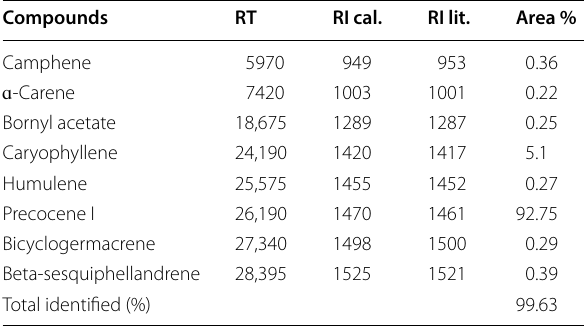
Table 1 Compounds found in the essential oil of Ageratum conyzoides L.